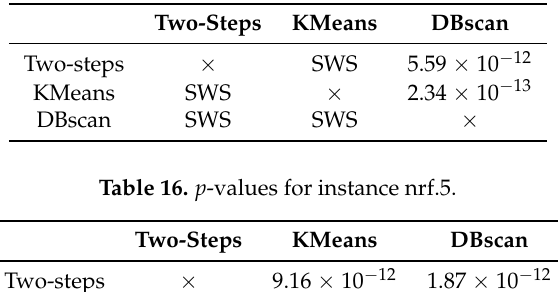
Table 15. p -values for instance nre.5.